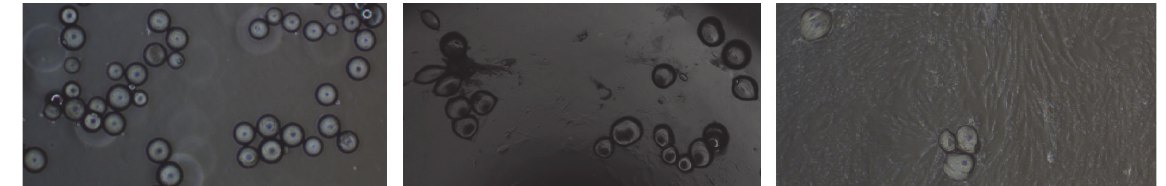
Figure 1: Phase contrast microscopy of human subcutaneous mature adipocytes undergoing dedifferentiation at various stages (4x) in ceiling culture at days 4, 7, and